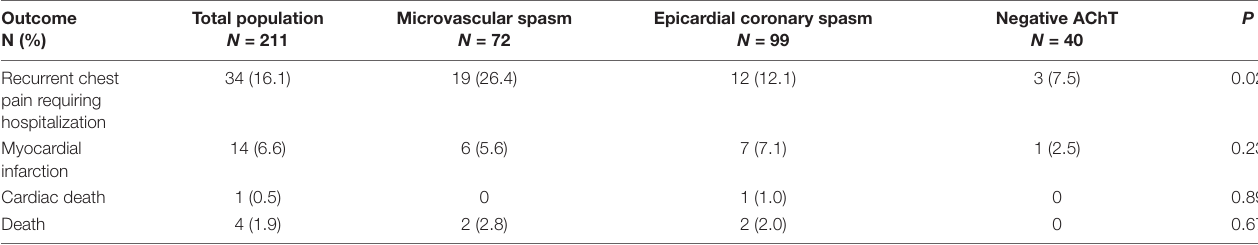
TABLE 4 | 5-year clinical outcomes based on